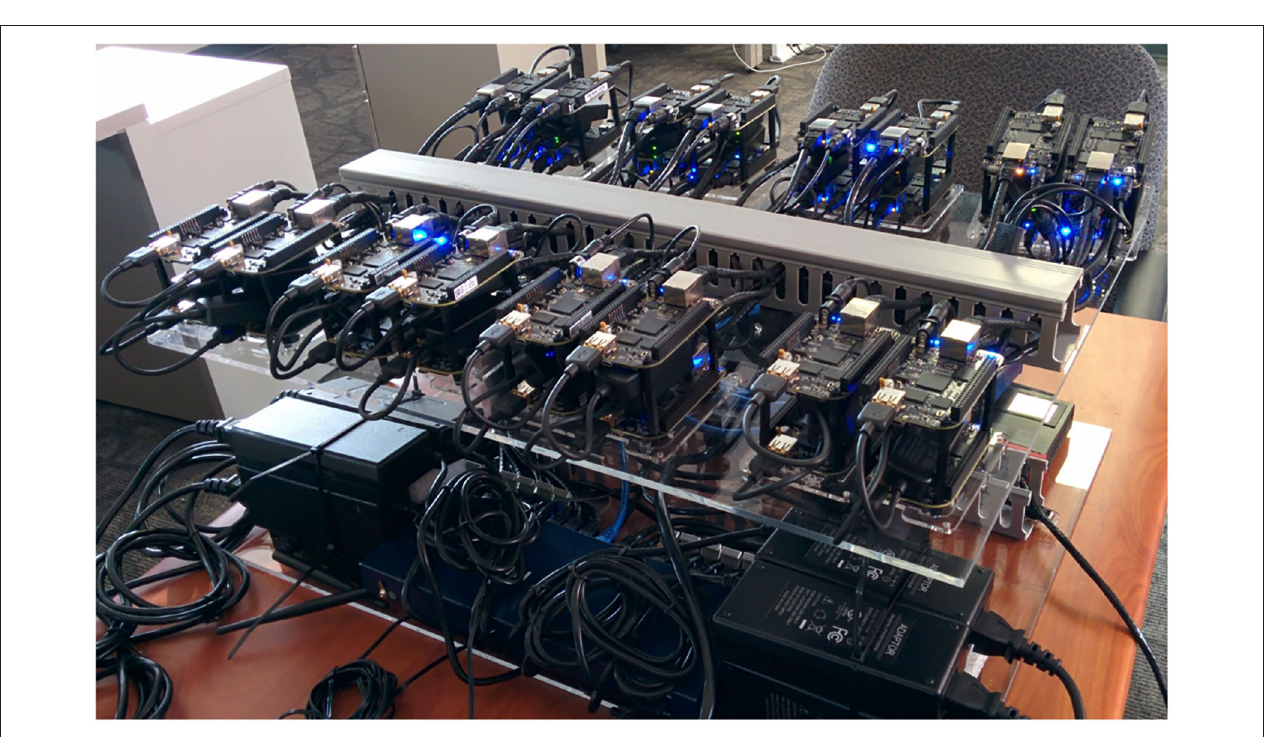
FIGURE 8 | Hardware